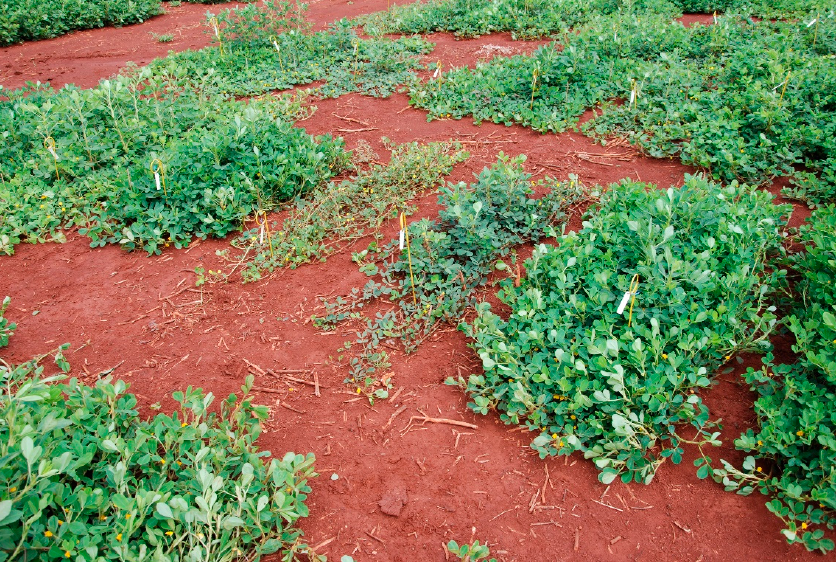
Figure 2. Plots with the interspecific RIL population ‘Runner IAC 886’ x IpaDur1; note the variation for growth habit and canopy among the plots. 231 232 Standard petal color is distinct for the wild diploid parents, with orange for the B genome A. 233 ipaënsis and yellow for the A genome A. duranensis . The allotetraploid AABB IpaDur1 has yellow 234 petals, while the cultivated parent ‘Runner IAC 886’ has orange petals. The F 1 resulting from the cross 235 between ‘Runner IAC 886’ and IpaDur1 also has yellow standard. Considering these observations, 236 we tested the hypothesis for a single-gene inheritance of standard petal color in peanut, with yellow 237 being dominant over orange, and using this population as a test cross. The segregation observed in 238 the 87 F 9 RILs was 39 yellow and 48 orange, fitting the 1:1 standard ratio according to the chi-square 239 test (P=0.335). 240